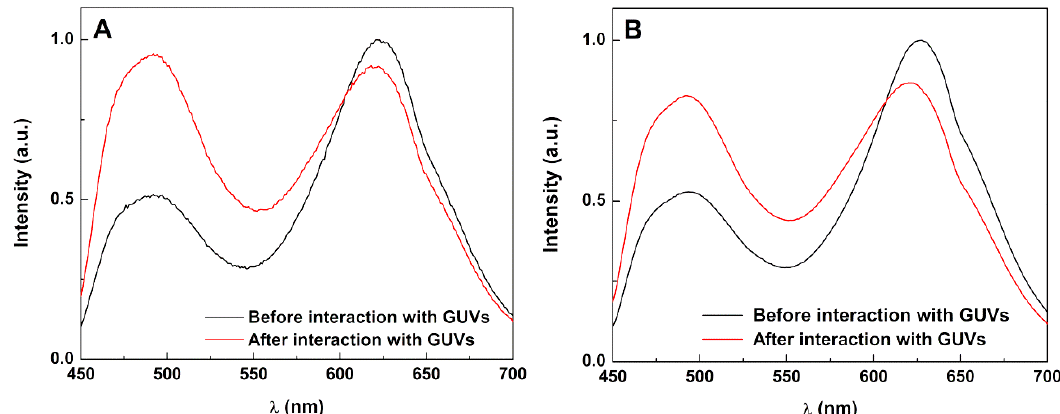
Figure 7. Fluorescence spectra ( λ exc = 440 nm) of aqueous magnetoliposomes (AMLs) containing Ca 0.25 Mg 0.75 Fe 2 O 4 nanoparticles (as an example), labelled with both curcumin (2 × 10 − 6 M) and Nile Red (2 × 10 − 6 M), before and after interaction with giant unilamellar vesicles (GUVs). ( A ) Aqueous magnetoliposomes (AMLs) of Egg–PC; ( B ) AMLs of Egg–PC / DSPE-PEG2000 (0.95:0.05).